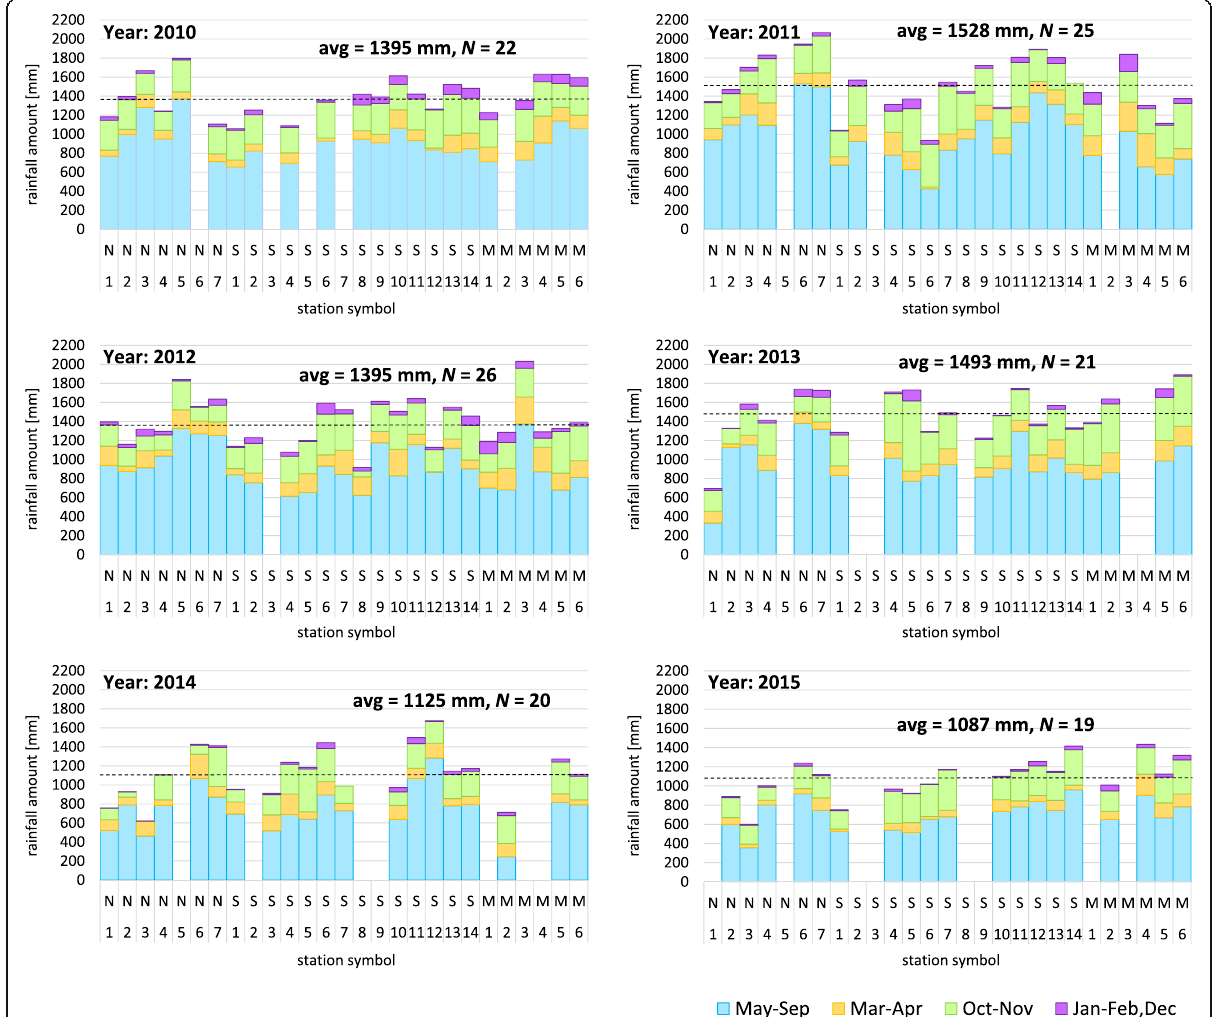
Fig. 4 Annual rainfall observed at each rain gauge in inland Cambodia from 2010 to 2015. Rainfall amounts from May to September (summer monsoon season, in blue), in March and April (pre-monsoon season, in orange), in October and November (post-monsoon season, in green), and in January, February, and December (dry season, in purple) are shown. The station symbol of each station is shown on the horizontal axis. Data in “ data-missing years ” have been excluded, and the number of available rain gauges, N , and annual rainfall amount averaged over available inland rain gauges (except for station C1) are shown in each panel with a broken black